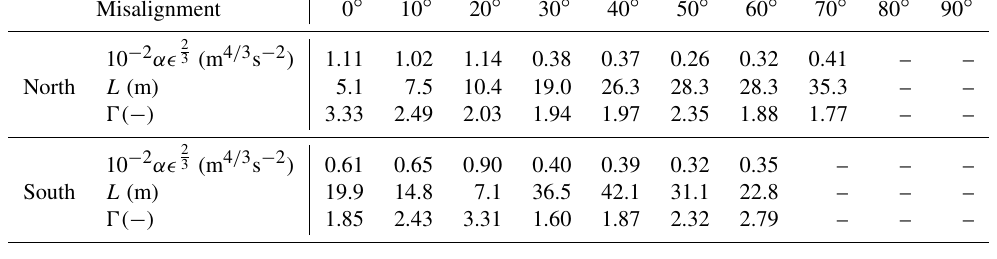
Table 2. Sector-wise fitted parameters of the Mann model for each beam to data obtained from sonic measurements at 10m over 2 months. Misalignment 0 ◦